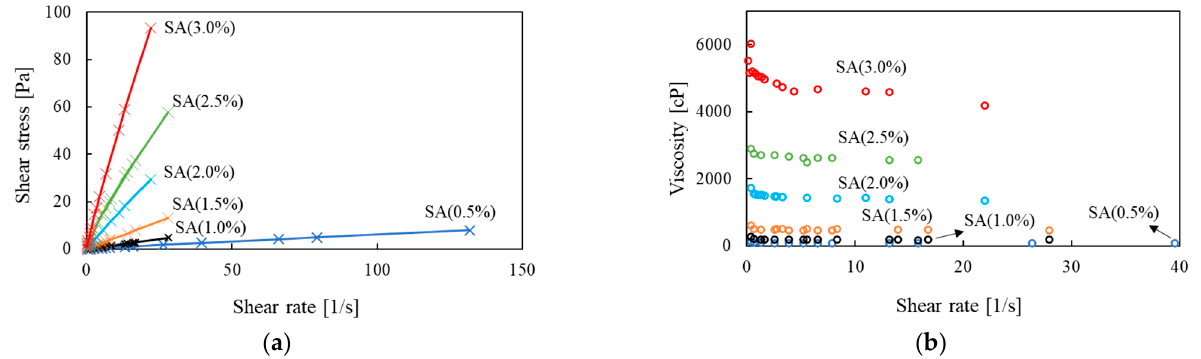
Figure 11. Shear rate of various sodium alginate (SA) solution concentrations versus ( a ) shear stress, ( b ) viscosity. Table 6. Fitting parameters using power-law model for various SA solution concentrations.